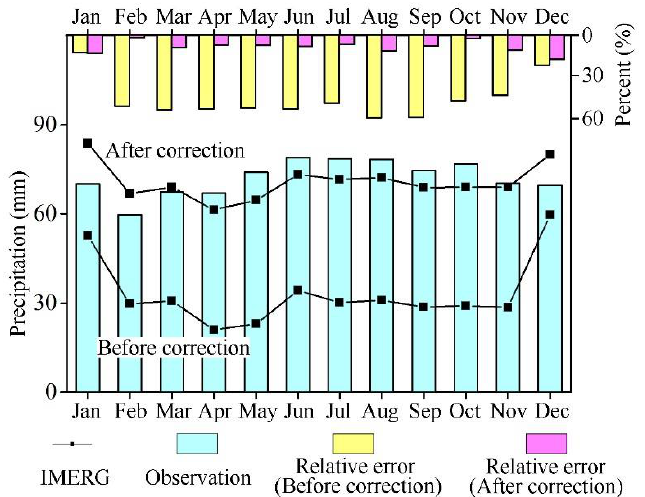
Figure 9. Difference comparison of monthly precipitation products before and after correction.